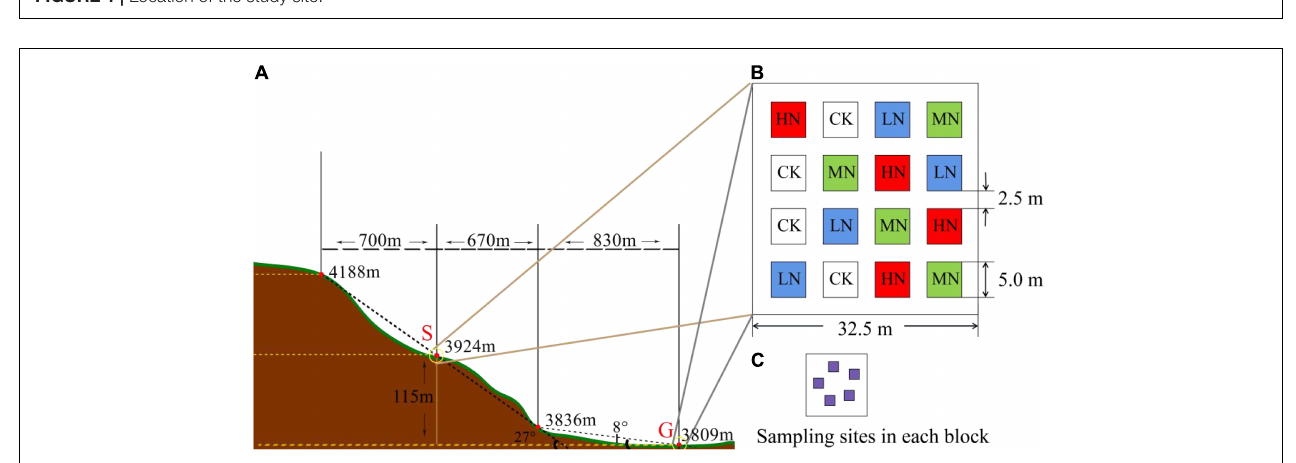
Illumina Miseq PE300 (Illumina, Inc., CA, United States)